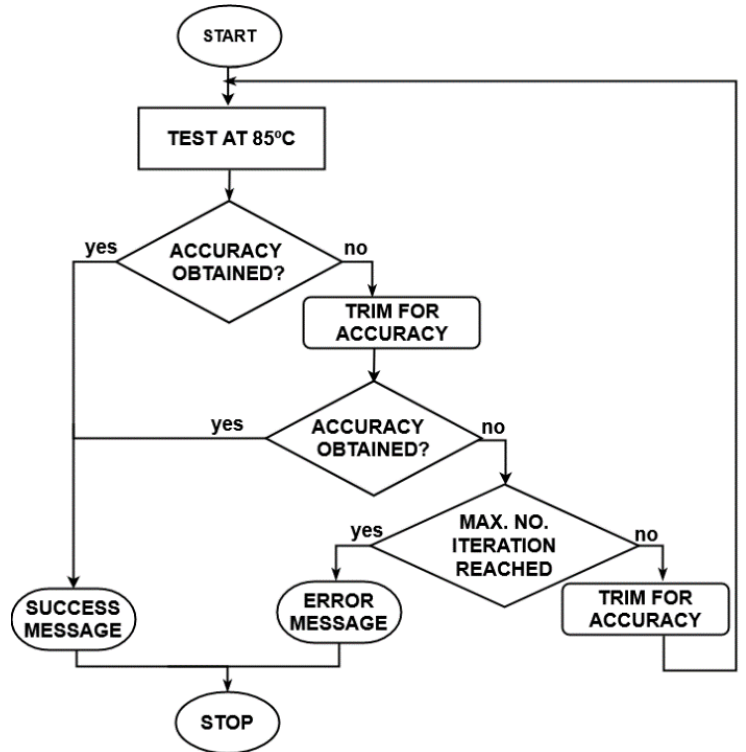
Figure 7. One-point calibration diagram.